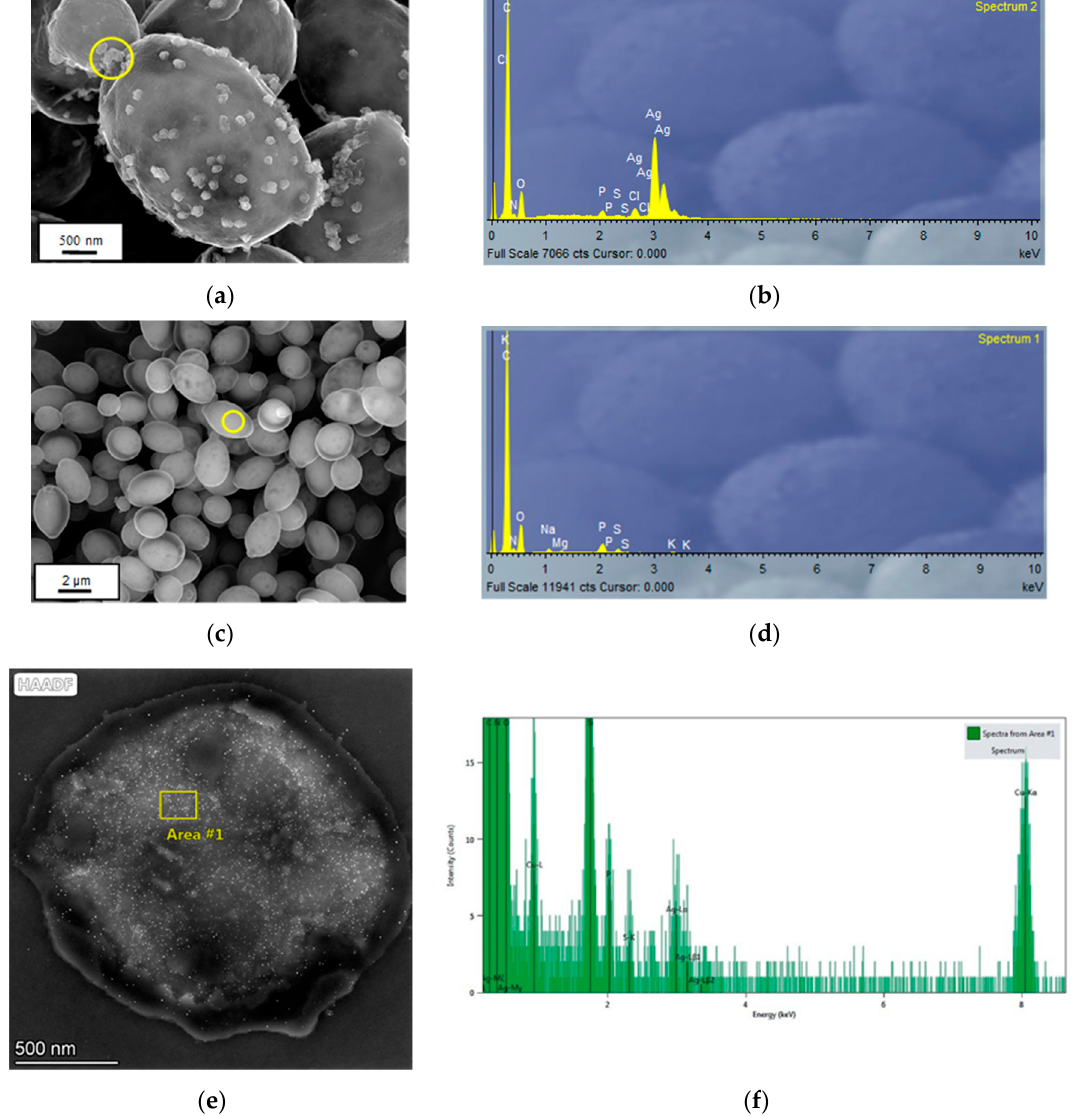
Figure 5. FESEM images of Rhodotorula mucilaginosa 1S1 cells and their corresponding EDX spectra obtained in the marked areas. ( a , b ) after the Ag(I) biosorption process, ( c , d ) before the process. ( e ): TEM-HAADF image of a Rhodotorula mucilaginosa 1S1 cell after the Ag(I) biosorption step. ( f ): EDX spectrum of the marked area in Figure 5e.